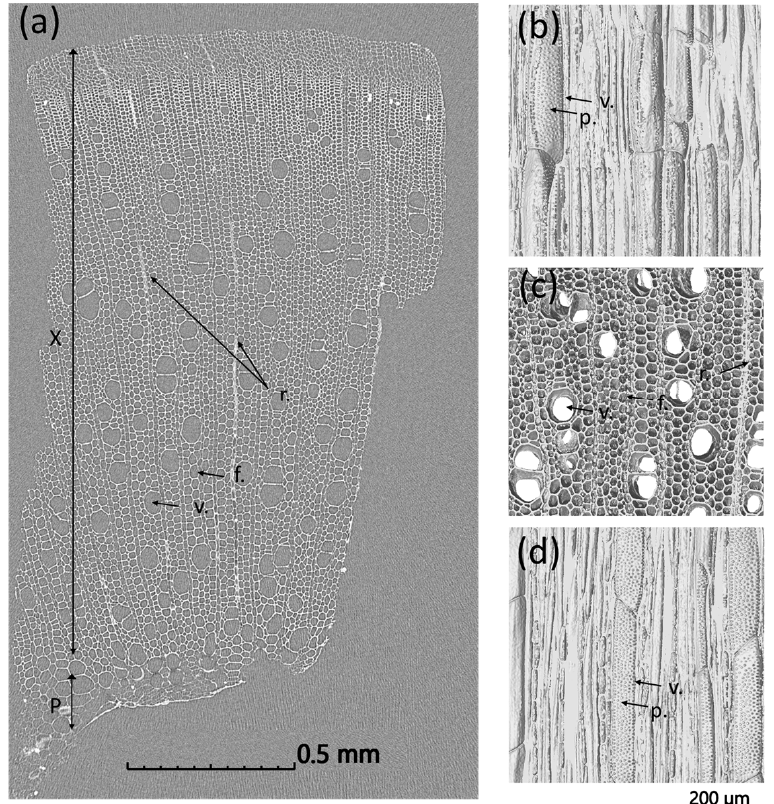
Figure 3. X-ray nanotomography image of the transverse cross-section of a hemp SHI-W sample showing the different tissues and cell types ( a ) and X-ray computed nanotomography images of a sample in L-R ( b ), R-T ( c ) and L-T ( d ) planes (X: xylem, P: pith, v.: vessel, f.: fiber, r.: ray and p.: pit).